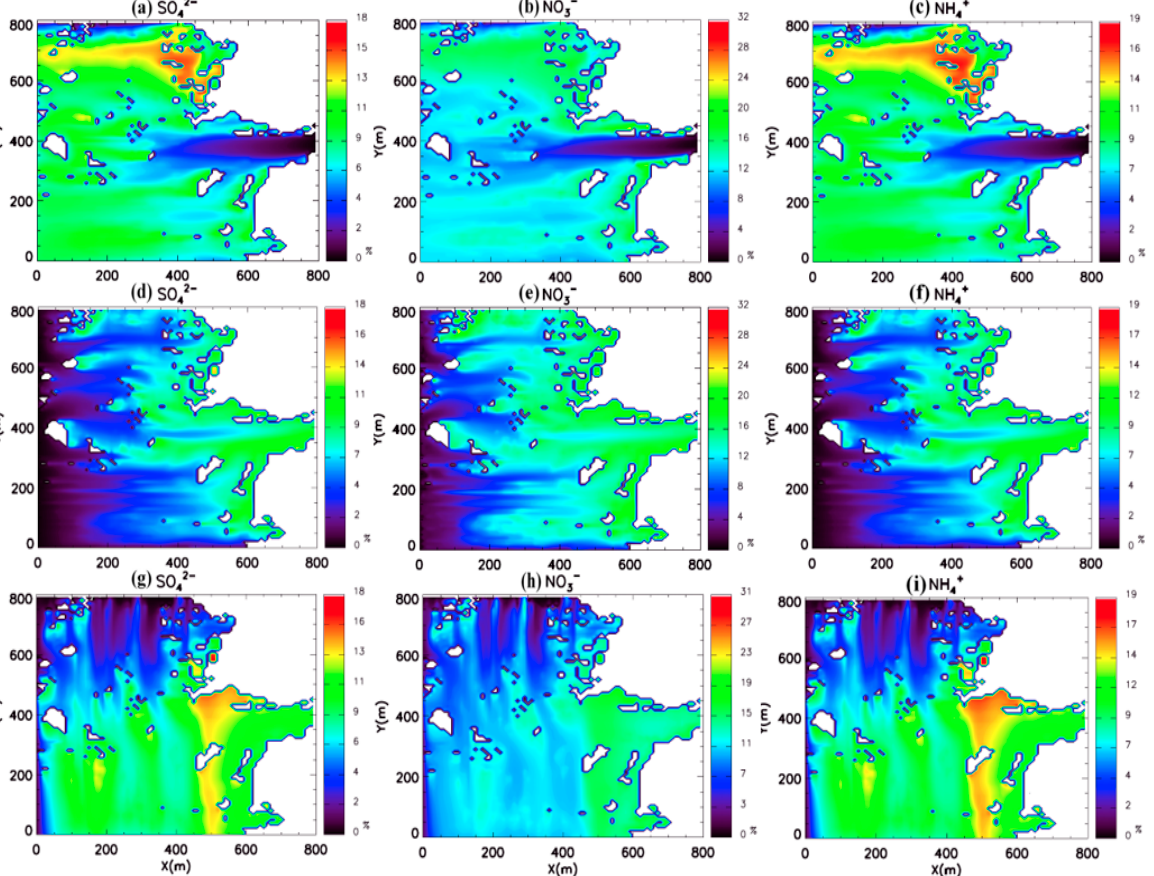
Figure 10. Reduction rate (%) of surface secondary inorganic aerosol (SIA) concentration in different wind direction cases. The surface reduction rates of ( a ) sulfate, ( b ) ammonium, and ( c ) nitrate in the east wind case. Surface reduction rates of ( d ) sulfate, ( e ) ammonium, and ( f ) nitrate in the west wind case. Surface reduction rates of ( g ) sulfate, ( h ) ammonium, and ( i ) nitrate in the north wind case. Table 7. Maximum and average concentration reduction ratio (%) depending on wind direction by species. Maximum Reduction Ratio of Concentration (%) Wind Direction